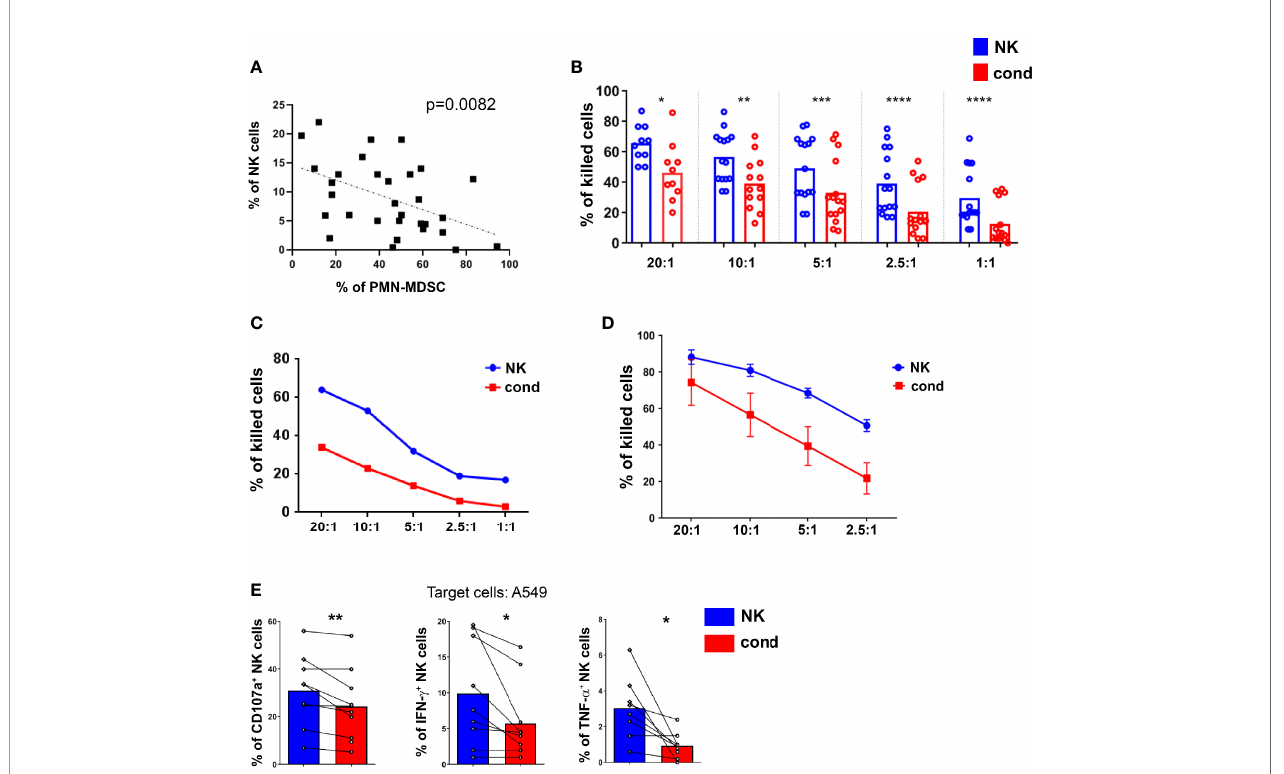
FIGURE 2 | PMN-MDSC impair the anti-tumor activity of NK cells. (A) Correlation between the frequencies of PMN-MDSC and NK cells present in PB of lung tumor patients. P = 0.0082 (n = 31) (B – E) NK cells activated in vitro- expanded or ex vivo were cultured alone (NK) or in the presence (ratio 1:1) of PMN-MDSC (cond.) derived from PB of lung tumor patients. After 48h of co-culture, PMN-MDSC were depleted from 1:1 co-cultures and the resulting NK cells used as effector cells in the different functional assays. (B, C) Percentages of killed NALM-18 target cells. (B) Statistical analysis of 15 independent experiments. (C) One representative experiment out of 15 performed. (D) Percentages of killed NALM-18 target cells of short-term NK cells conditioned or not with PMN-MDSC derived from PB of lung tumor patients (n = 3). The different Effector/Target (E/T) ratios are indicated. (E) Cytokine production and degranulation capabilities of NK and cond. cells were analyzed after 4h of co-culture with A549 target cells. Bars indicated percentage of median of cytokines production (IFN- g and TNF- a ) and degranulation (CD107a) of NK and cond. cells (n = 9). *p ≤ 0.05; **p ≤ 0.005; ***p ≤ 0.0005; ****p ≤